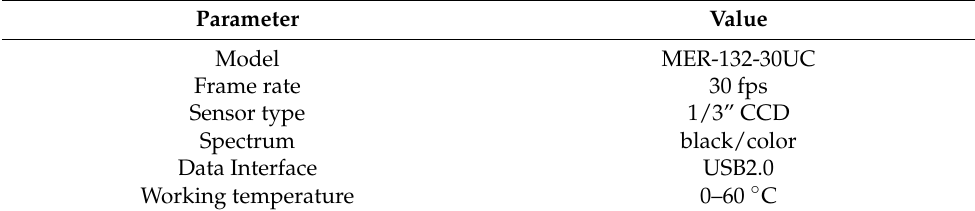
Figure 1. Daheng Industrial Camera: ( a ) overall camera; ( b ) camera base; ( c ) camera lens. Table 2. The basic parameters of the industrial camera.